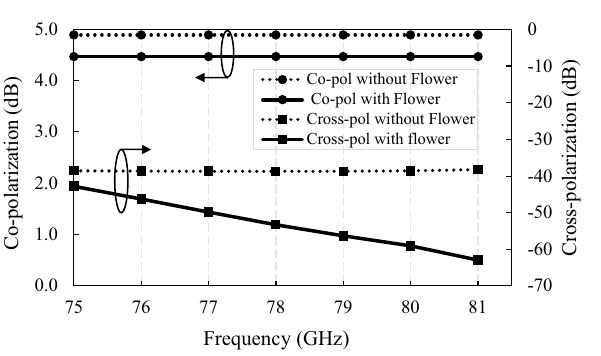
Figure 8. Comparison of cross-polarization and co-polarization versus frequency of the design with and without proposed flower